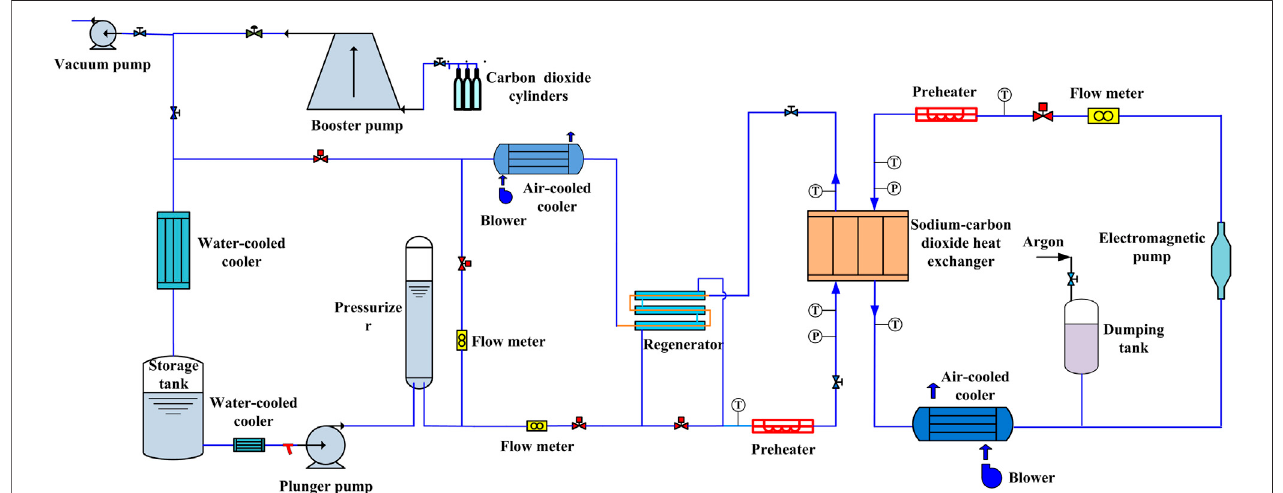
FIGURE 3 | Test system of the performance of the